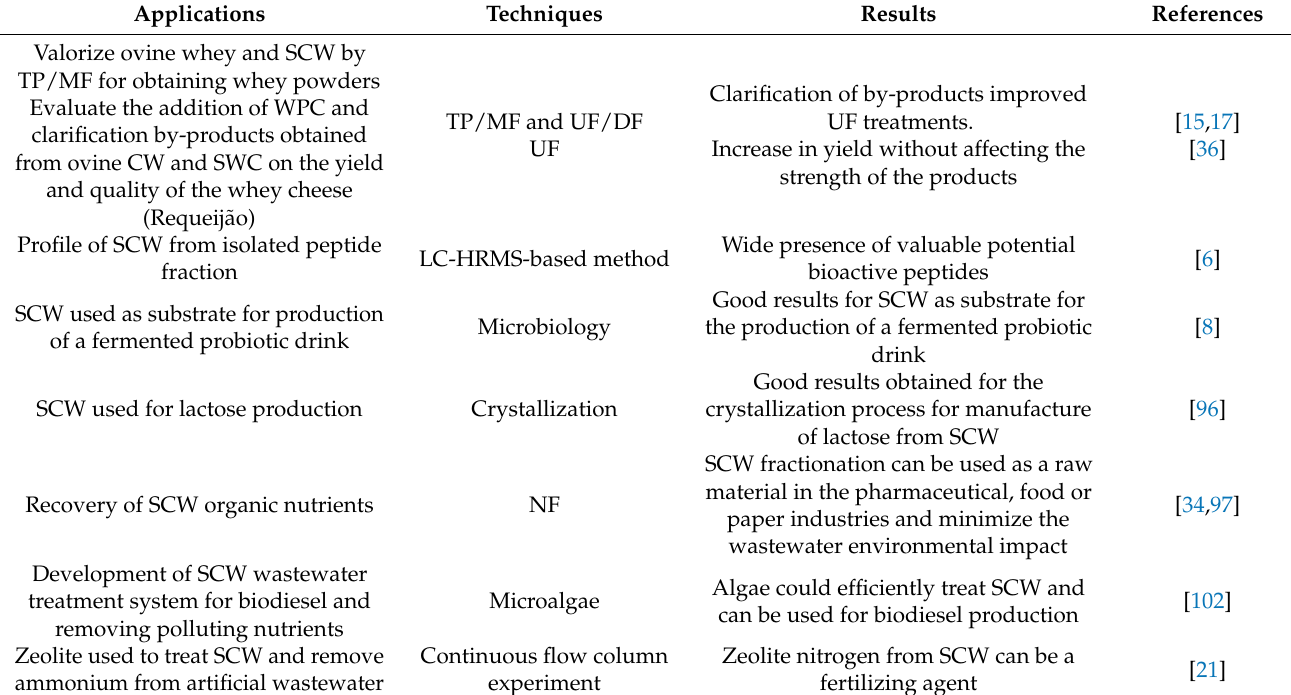
Table 6. Reports on the valorization and characterization of second cheese